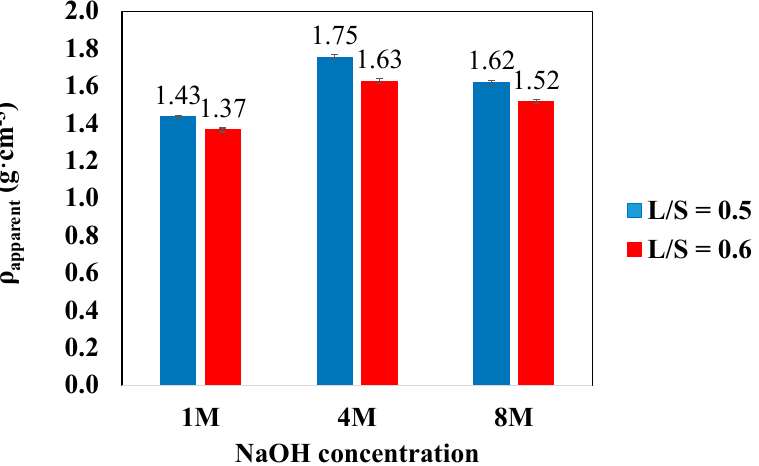
Figure 6. Apparent density results of the different AAC formulations obtained, depending on the L/S ratios (0.5 and 0.6) and the NaOH